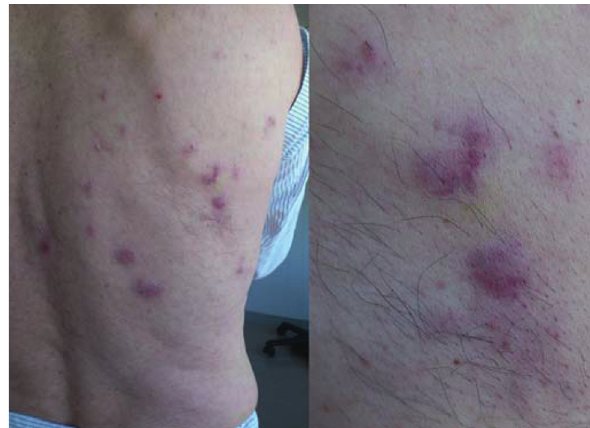
Figure 1: Erythematous, round, well-grouped plaques located at the rear right costal arch. A biopsy of the skin lesions was per- formed and reported as compatible with leukemia